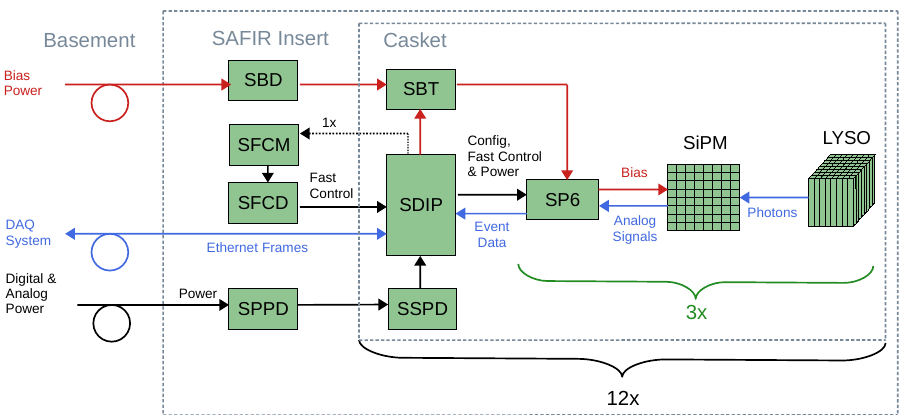
Figure 7. Schematic depicting the interaction of components within SAFIR-I. Each of the 12 SDIPs supports one SBT and three DHMs, consisting of LYSO scintillation crystals, MPPC SiPM arrays and SP6 PCB’s. These components are all connected to common supporting PCB’s in the detector’s end-flange. Bias, analog and digital power supplies as well as the DAQ system PC are located outside the insert within the service room in the